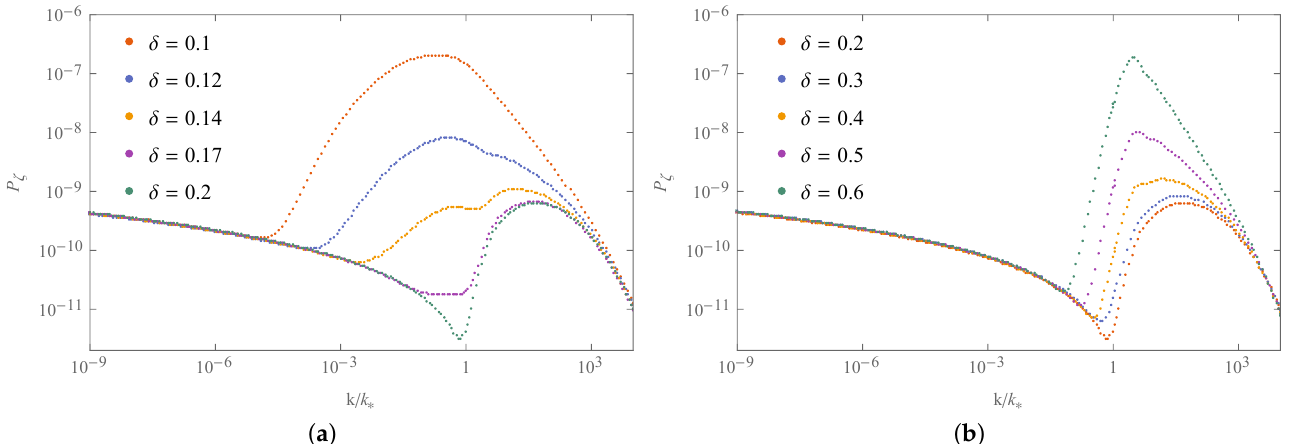
Figure 7. The power spectrum for some values of δ between 0.1 to 0.2 on the plot ( a ), and for other values of δ between 0.2 to 0.6 on the plot ( b ). The pivot scale is k ∗ = k ∆ N